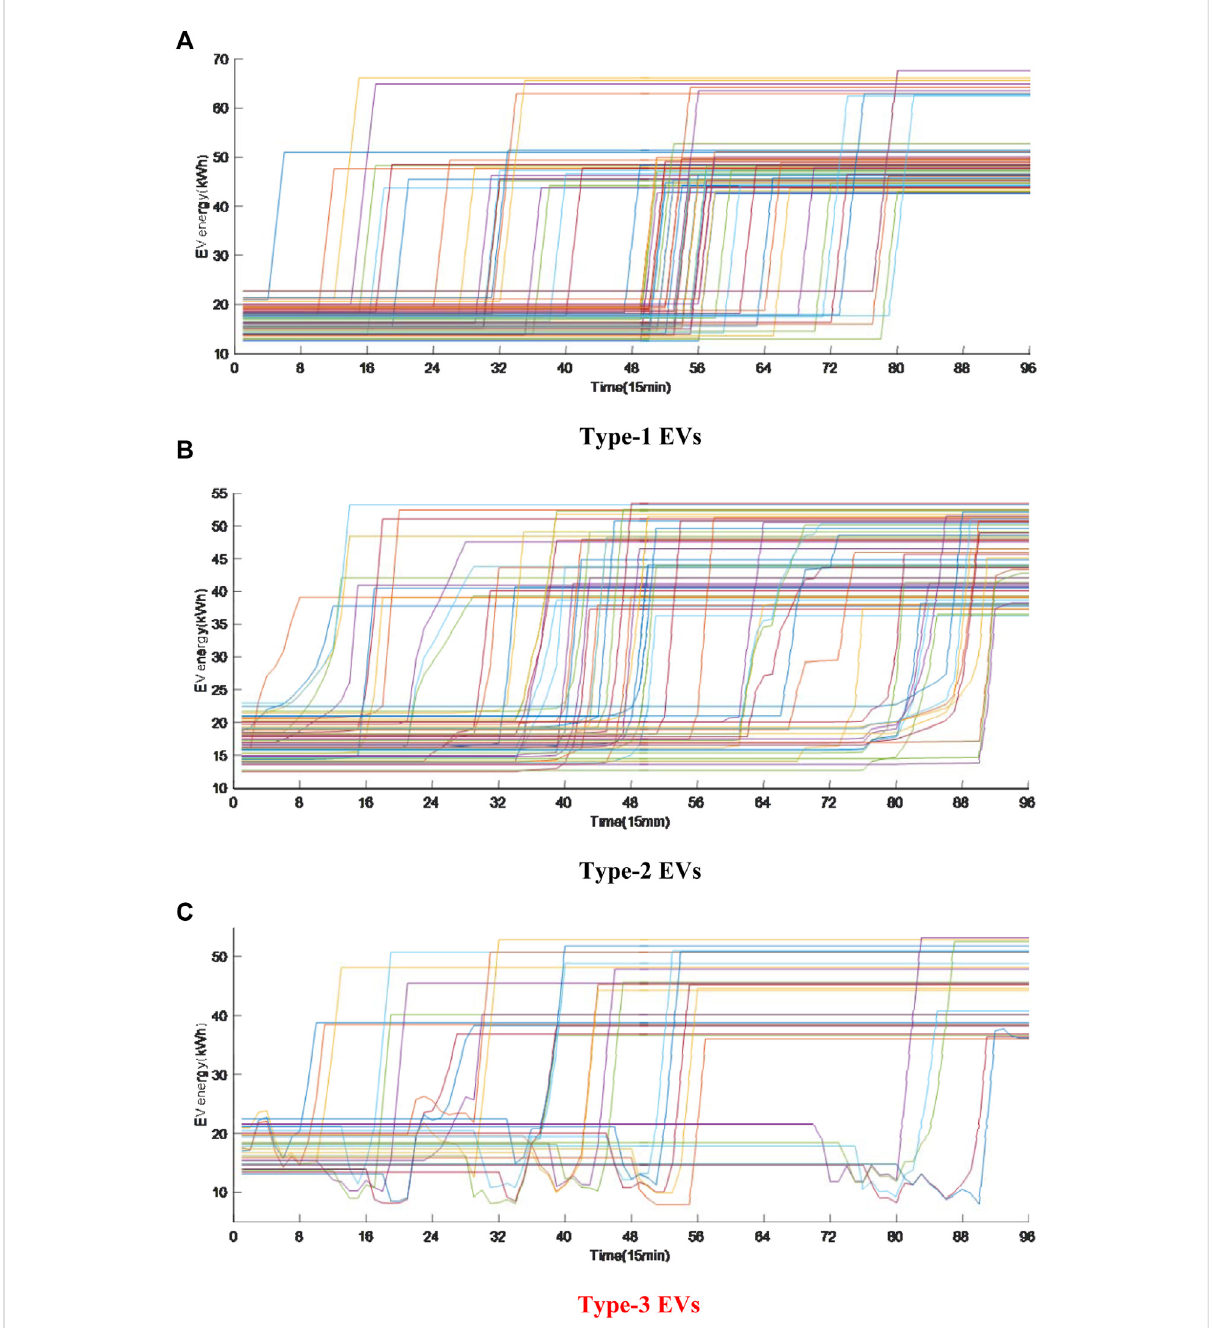
FIGURE 16 Energy curves of the EVs under the adaptive MPC scheduling strategy. (A) Type-1 EVs. (B) Type-2 EVs. (C) Type-3